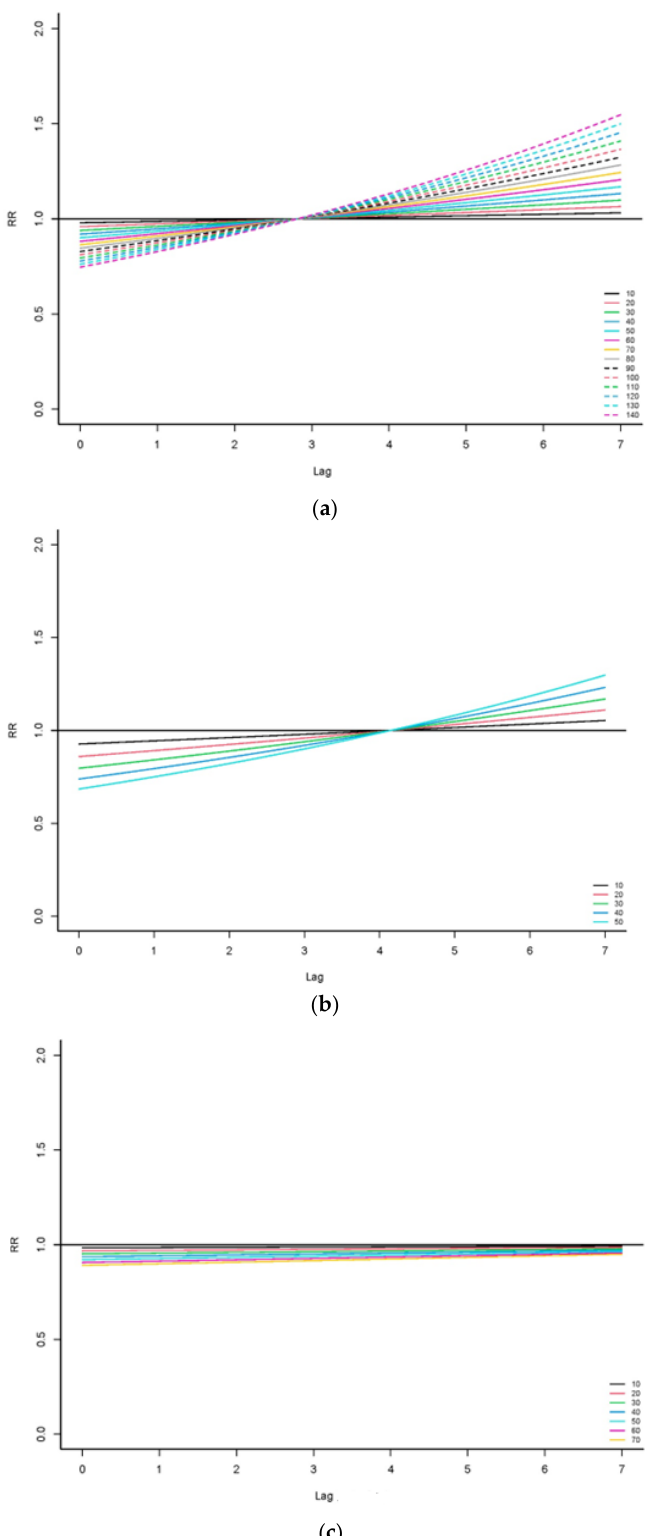
Figure 5. Lag effects of air pollutants on AECOPD hospitalization on multi-predictor models: ( a ) PM 2.5 UB; ( b ) SO 2 UB; ( c ) NO 2 . RR is represented on the vertical axis, lag days on the horizontal axis, and colored curves represent different concentrations of air pollutants. No statistically significant association can be observed.